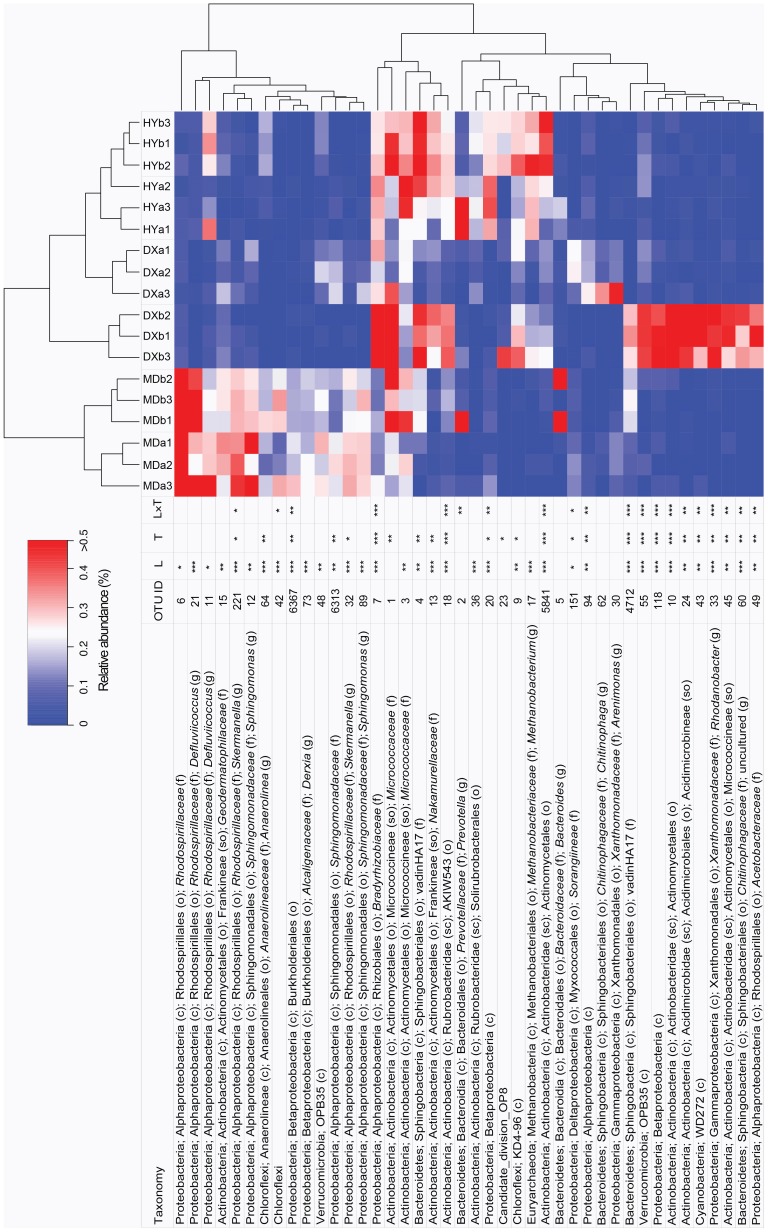
Heatmap showing the relative abundance of selected OTUs.The samples and OTUs are clustered according to Manhattan distances. The colors correspond to the relative abundance of the OTUs in the samples, as indicated by the color legend. The taxonomy of each OTU is provided to the lowest-level attained during the classification. Abbreviations are used to indicate class (c), order (o), suborder (so), family (f) and genus (g). Two-way ANOVA for each OTU was performed using location (L), topography (T) and location and topography (L×T). P-values of the ANOVA are indicated as follows: * (P<0.05), ** (P<0.01), *** (P<0.001).